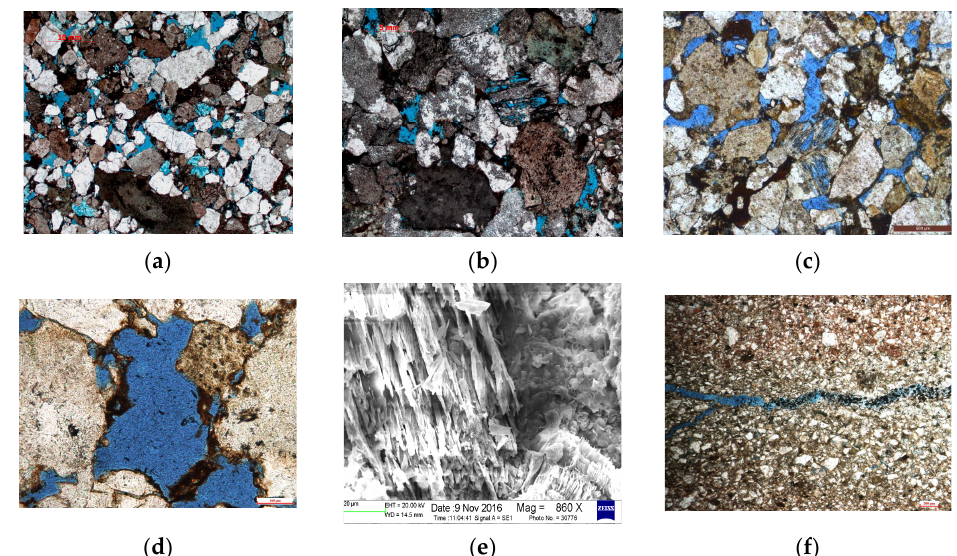
Figure 6. Pore types of reservoirs of Ek1 Formation in the Wang Guantun area. ( a ) Intergranular pore; ( b ) Intergranular dissolution pore; ( c ) Intergranular dissolution pore; ( d ) Mold pore; ( e ) Solution pores in feldspar; ( f ) Microcracks.